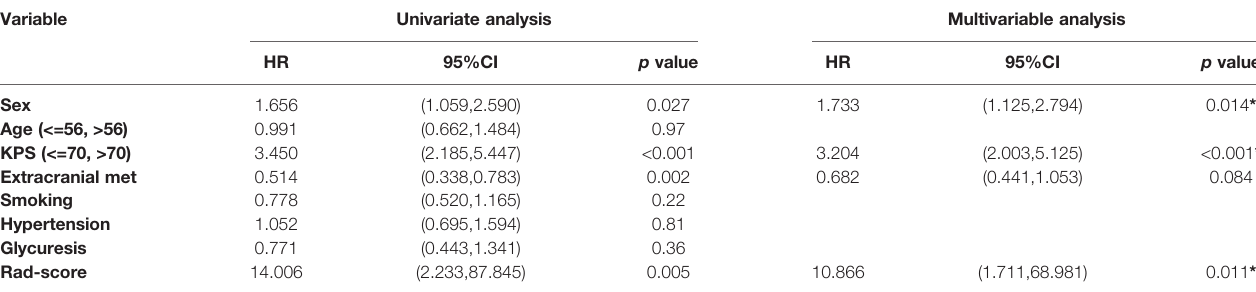
TABLE 3 | Univariate and multivariate Cox regression analysis for risk factors associated with overall survival.